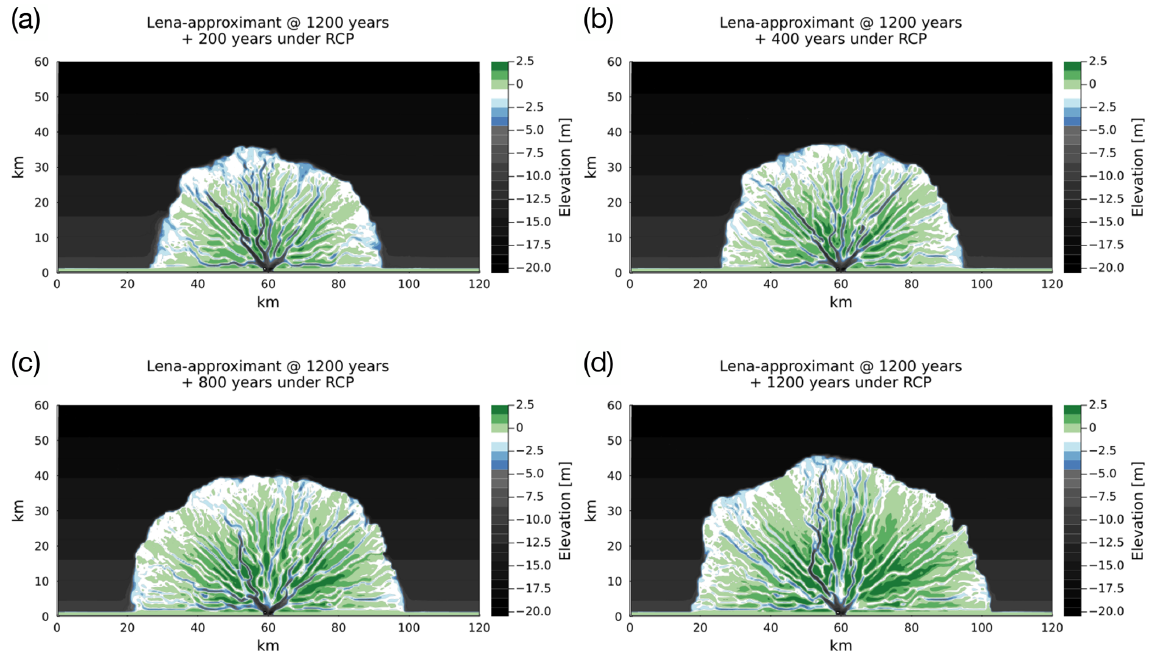
Figure 11. The continued evolution of the delta shown in Fig. 10, except now under conditions possible in an end-member climate-warming scenario (based roughly on RCP7 to 8.5). As before, coloured contours reflect the bed elevations. The four panels show (a) 200, (b) 400, (c) 800, and (d) 1200 model years into this continued portion of the simulation. Note the degradation and disappearance of the ramp feature.